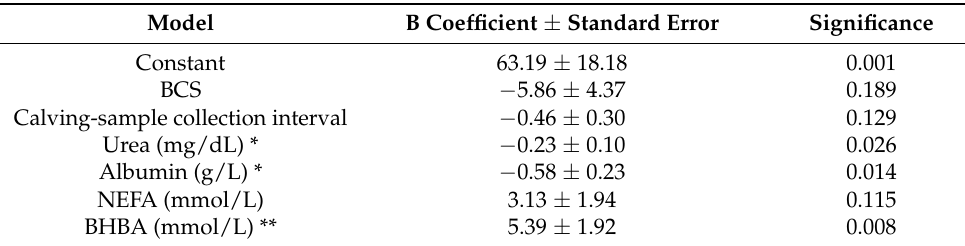
Table 2. Resulting model for the multiple linear regression analysis. The percentage of polymor- phonuclear neutrophils was selected as the dependent variable and the remaining factors as indepen- dent variables.